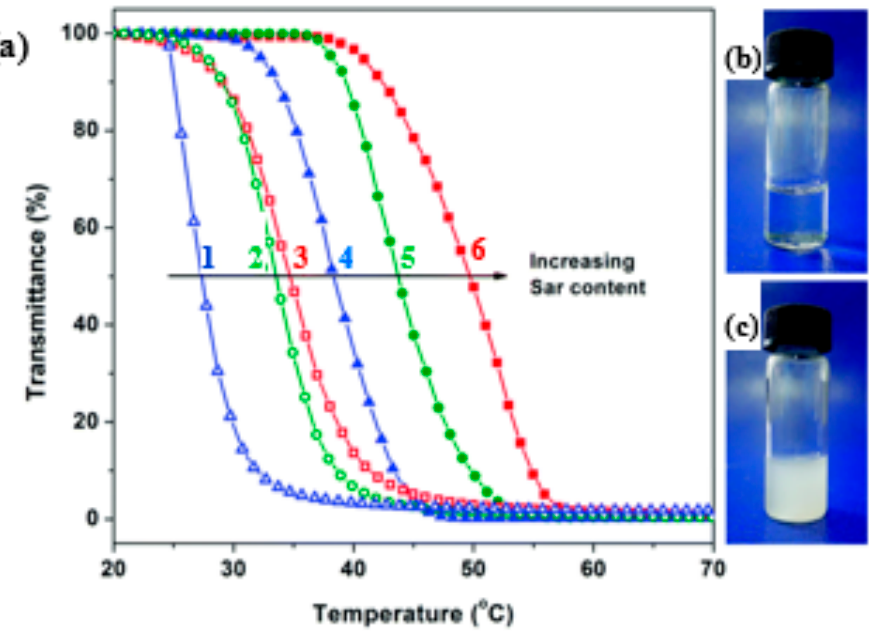
Figure 8. Transmittance changes at λ = 450 nm as a function of temperature for the selected aqueous solutions of P(Sar 96 - r -NBG 56 ) (1 and 4 in blue), P(Sar 104 - r -NBG 53 ) (2 and 5 in green), and P(Sar 108 - r -NBG 49 ) (3 and 6 in red) with a concentration of 3.0 mg/mL ( a ), where heating (4, 5, and 6) and cooling cycles (1, 2, 3) are symbolized by the filled and open symbols, respectively. The P(Sar- r -NBG) aqueous solution is photographed at 20 °C ( b ) and 50 °C ( c ). Reprinted with permission from [60] . Copyright 2015, Royal Society of Chemistry.